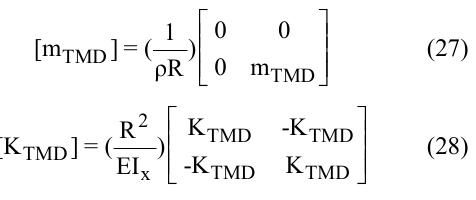
Figure 3. The curved beam with a vibration